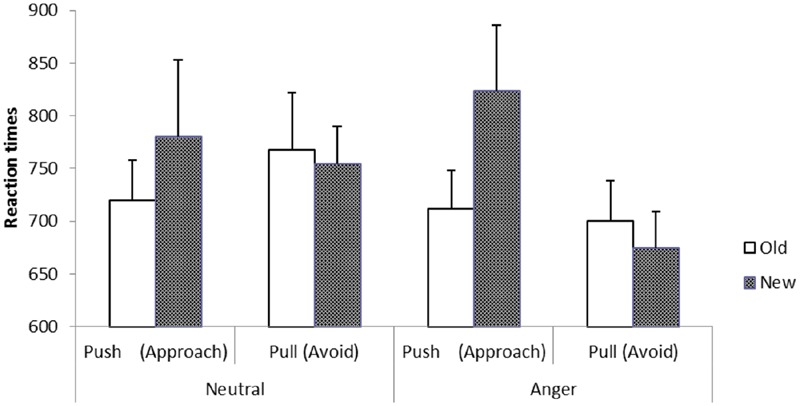
Reaction times to perform pushing and pulling motions in response to familiar (Old) and novel (New) targets for each stimulus type (Experiment 1).